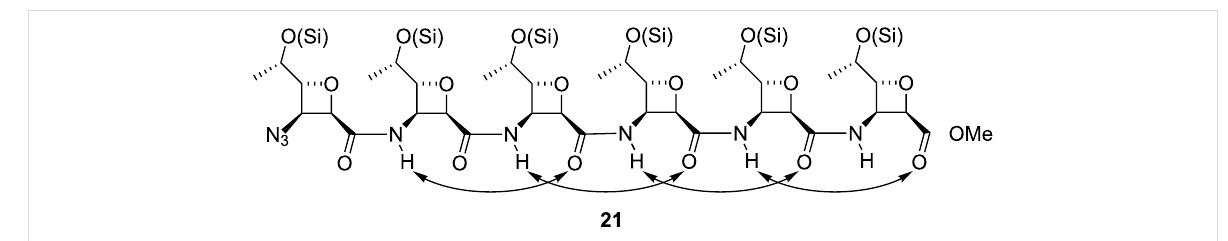
Figure 8: 10-Membered ring H-bonds in compound 21 consistent with NMR and modelling investigations.